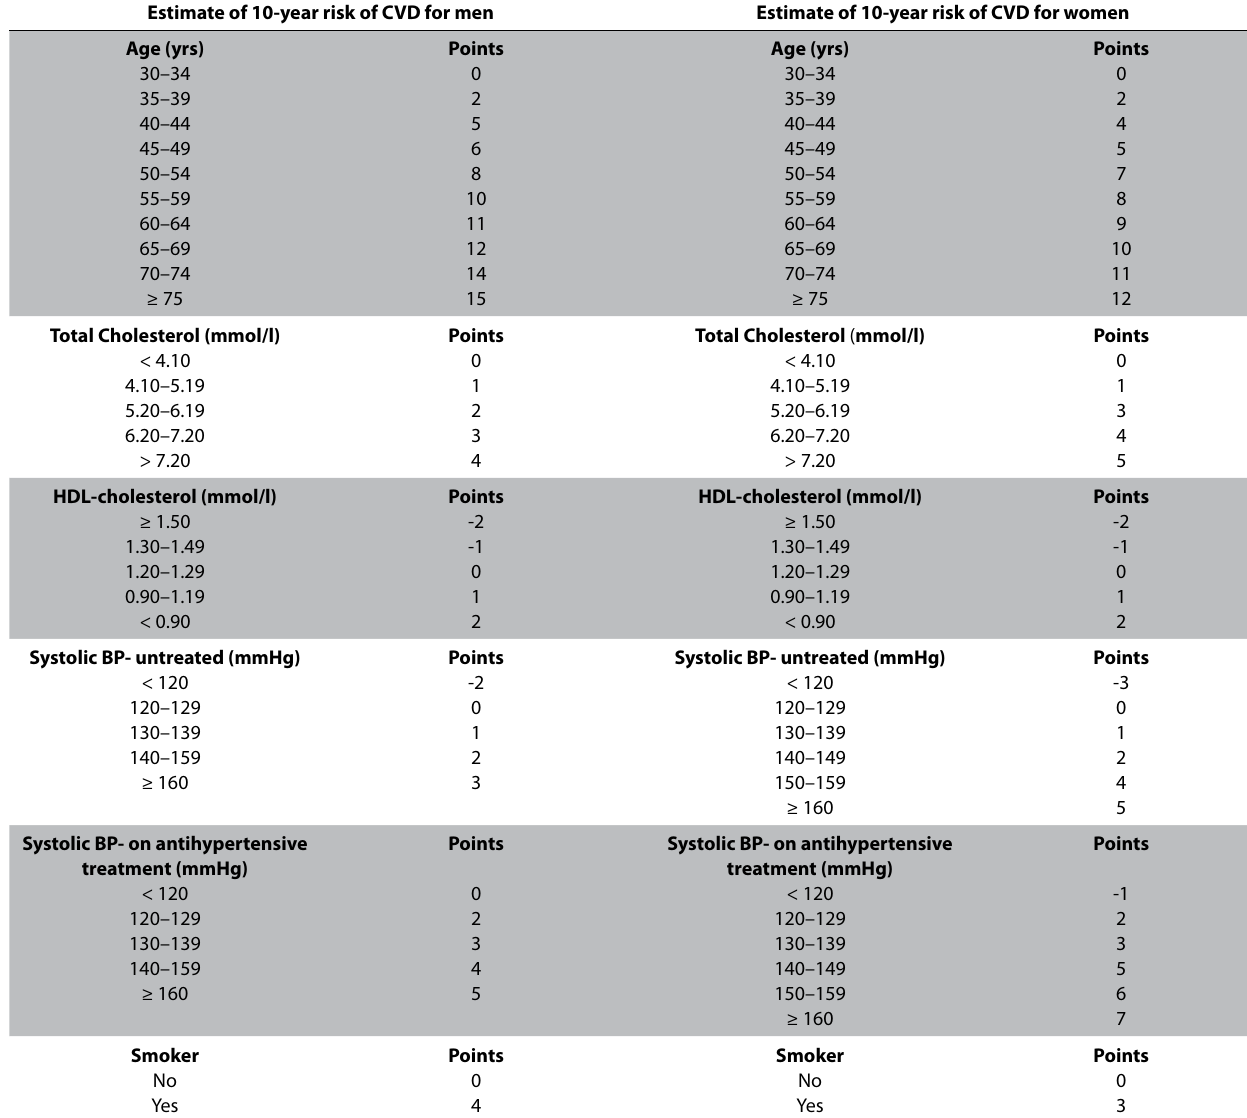
Table 7: Updated Framingham CVD risk tables for men and women Estimate of 10-year risk of CVD for